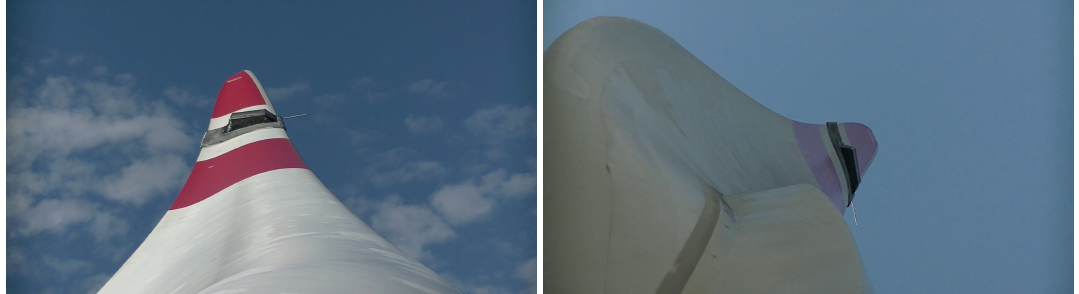
Figure 7. View from optical camera on the spinner of the pressure side of the blade at R = 35 m. Black box contains the entire data-recording system, including power supply. Chord there is 1.5 m. In addition, orientation of the five-hole probe relative to vertical axis (approximate rotor plane) indicates the instantaneous pitch to be compared with values from the Supervisory Control and Data Acquisition (SCADA) system. ( Left ) WT in standstill; ( Right ) WT in operation.